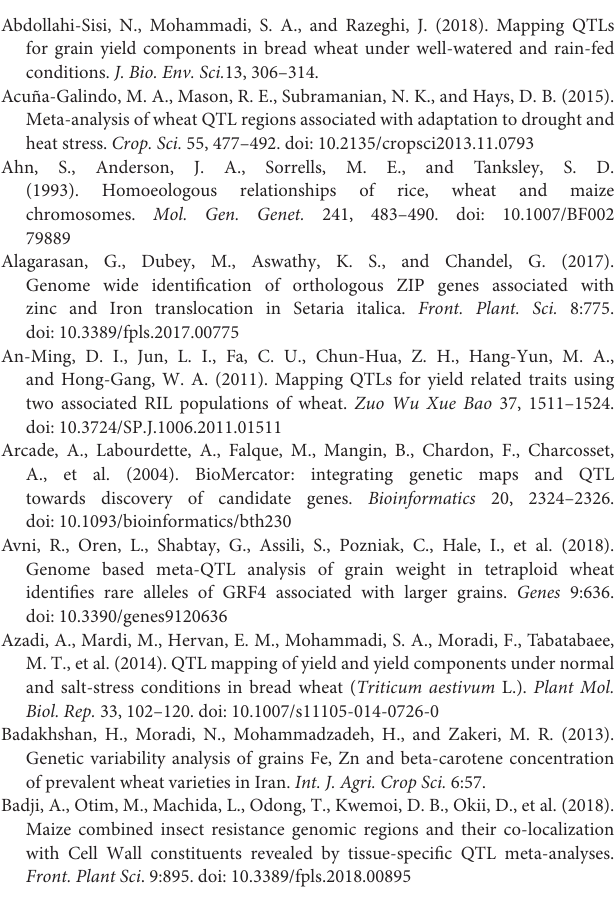
Supplementary Table 3 | The information of QTLs in the detected MQTLs.